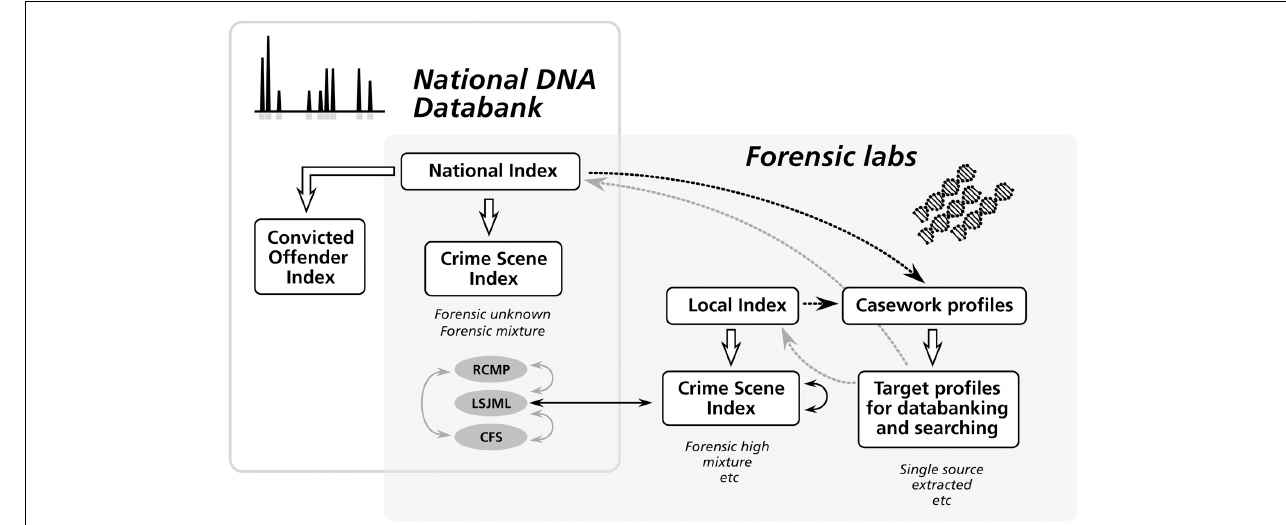
FIGURE 1 | The architecture of the National DNA Data Bank in Canada and its relationship to forensic laboratories. The bank is a national repository composed of two indexes. The Convicted Offender Index is managed centrally at the national level, while the National Crime Scene Index (CSI-nat) is managed collectively by three forensic labs (RCMP, LSJML, and CFS), with each lab being responsible for the profiles generated under its jurisdiction. The CSI-nat allows for inter-jurisdictional comparisons of crime scene profiles (solid gray arrows). The Local Crime Scene Index (CSI-loc)